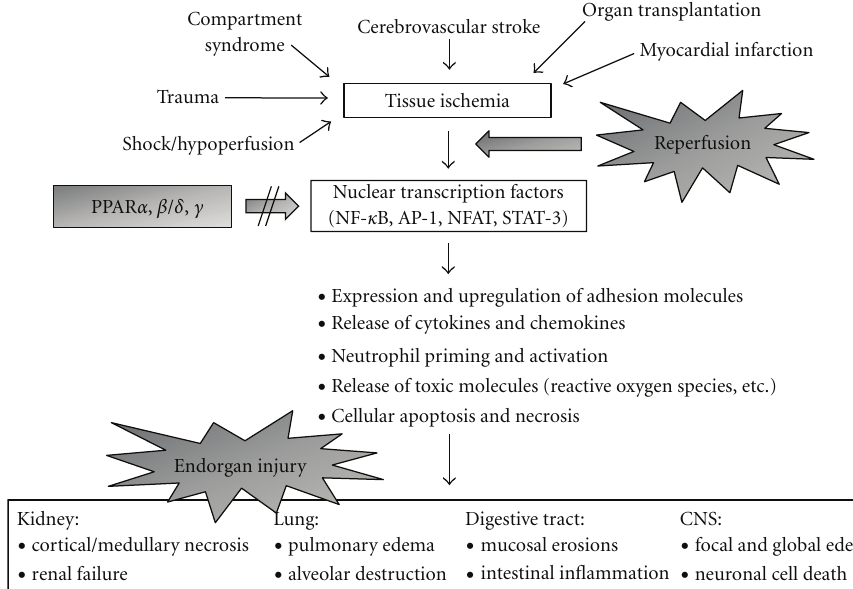
Figure 2: Schematic depiction of the inflammatory events occurring during the pathophysiology of ischemia/reperfusion (I/R) injury, and potential pharmacological e ff ects of PPAR ligands, by inhibition of nuclear transcription factors. See text for detailed explanations. Abbreviations: PPAR , peroxisome proliferator-activated receptor ; CNS , central nervous system ; NF- κ B , nuclear factor- κ B ; AP-1 , activator protein-1 ; NFAT , nuclear factor of activated T cells ; STAT-3 , signal transducer and activator of transcription-3